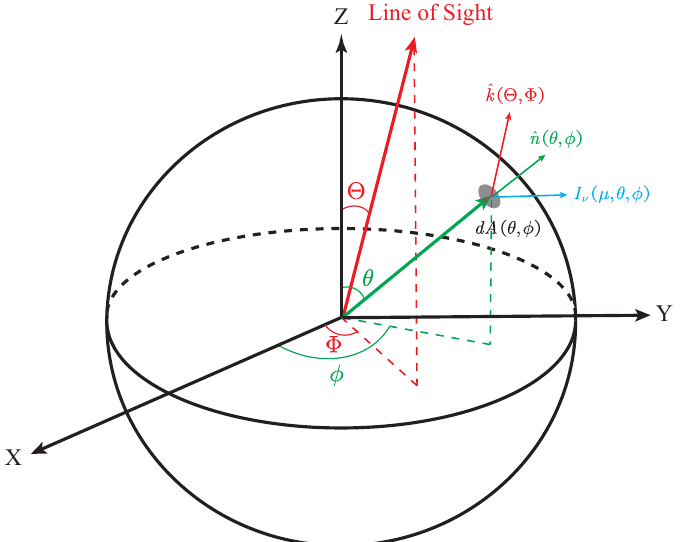
Figure 2. The sketch of the coordinate system we use, the angles Θ and Φ represent the direction of line of sight, the angles θ and φ represent the location of a point in local